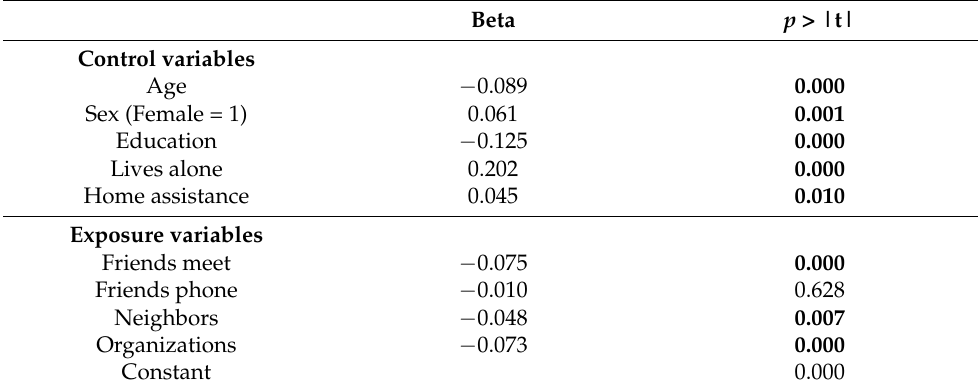
Table 1. Regression on an index of mental health in the full sample ( n = 3033) 1 .